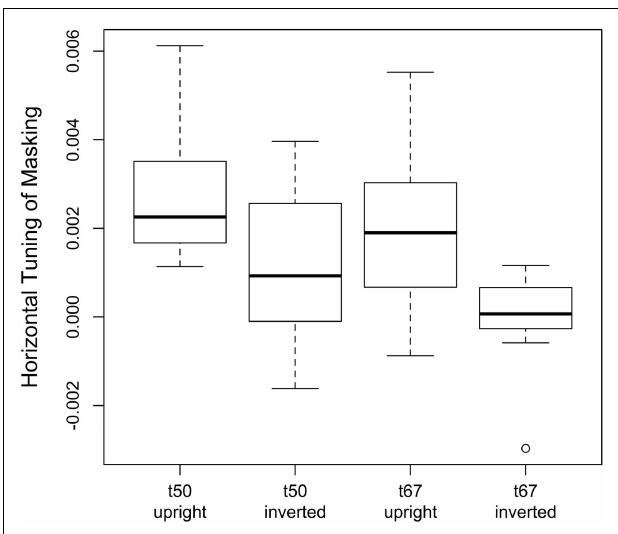
FIGURE 4 | Orientation tuning of masking for upright and inverted faces in the t 50 and t 67 groups. Tuning was defined as the slope of the regression line fit to masking obtained with noise orientations of − 90˚, 67.5˚, 45˚, 22.5˚, and 0˚. Masking values at 67.5, 45, and 22.5 were defined as the average level of masking obtained at, respectively, ± 67.5˚, ± 45˚, and ± 22.5˚.The horizontal line in each boxplot indicates the median; the upper and lower edges of each box indicate the 75th and 25th percentile,